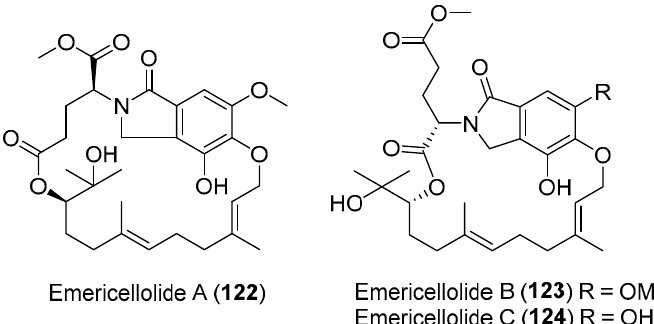
Figure 21. Structures of emericellolides A–C ( 122 – 124 ).